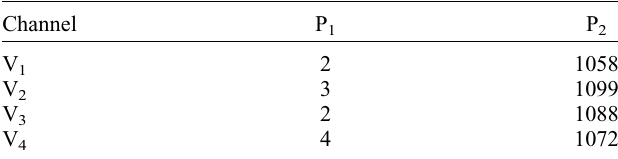
Table 4. Correction factors for EUV instrument gain